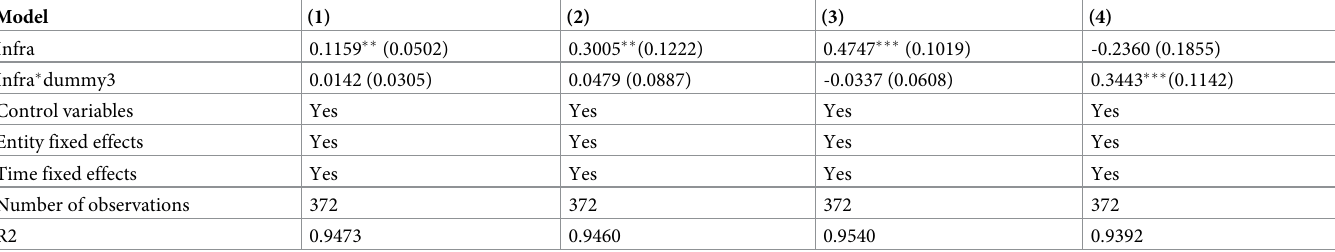
Table 8. Impact of infrastructure scale on tourism industry